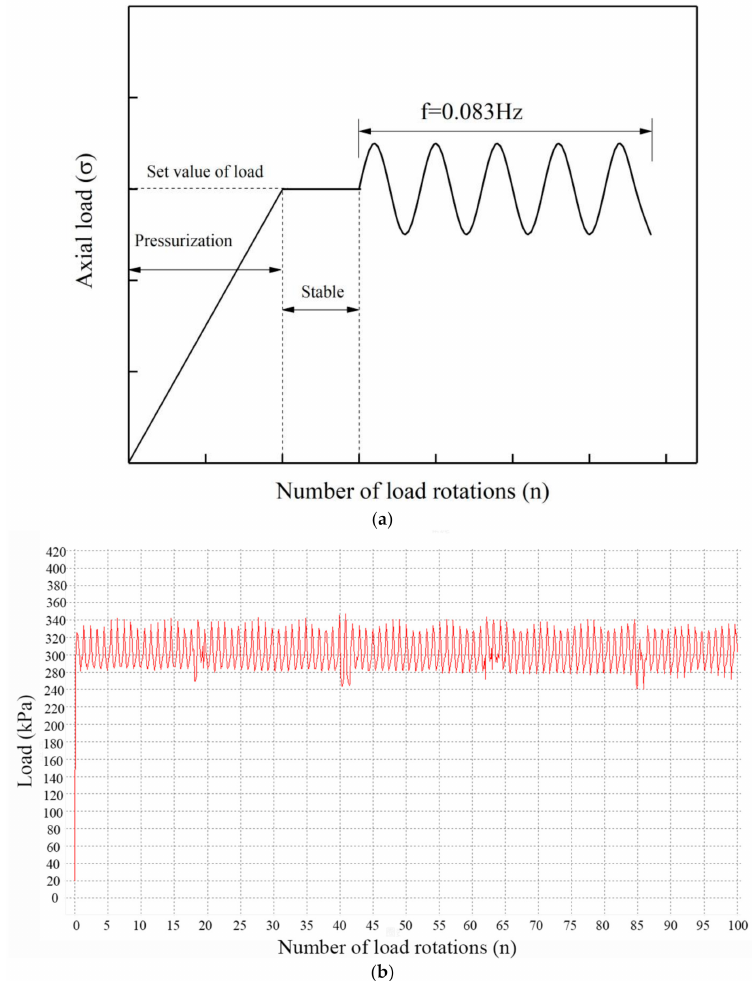
Figure 7. ( a ) Loading process and test load waveform; ( b ) real-time load during cyclic rotating axial compression.